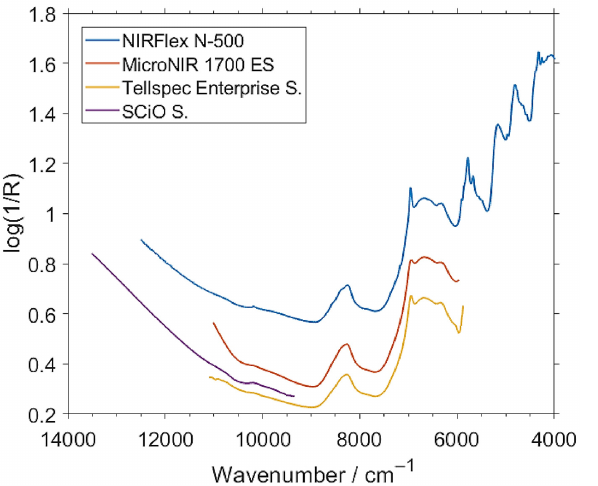
Figure 8. Unpretreated NIR spectra of exemplary intact insect protein fitness bar samples measured by a benchtop NIRFlex N-500 and three miniaturized (MicroNIR 1700 ES, Tellspec Enterprise sensor, and SCiO sensor) spectrometers. The two latter sensors are cost-effective designs specifically intended for food analysis by consumers. Reproduced (CC-BY 4.0 license) from [73]. Table 11. The parameters of the regression models constructed for the fused spectral data from the two cost-effective miniaturized NIR spectrometers (Tellspec Enterprise sensor and SCiO sensor) for the analysis of protein content in intact and milled bars. Analyzed protein concentration range: 19.3– 23.0 % ( w / w ). Reproduced (CC-BY 4.0 license) from [73]. Intact Milled PLSR GPR PLSR GPR SNV, SG2 Pretreatment (25 SP)